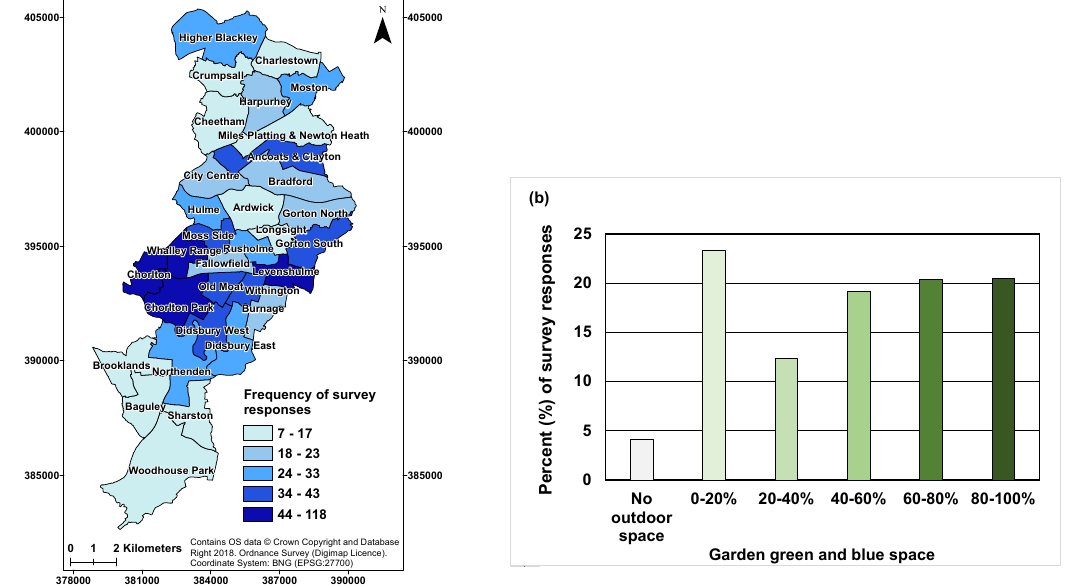
Figure 5. Citizen Science Survey responses ( a ) by ward; ( b ) by proportion of garden green and blue